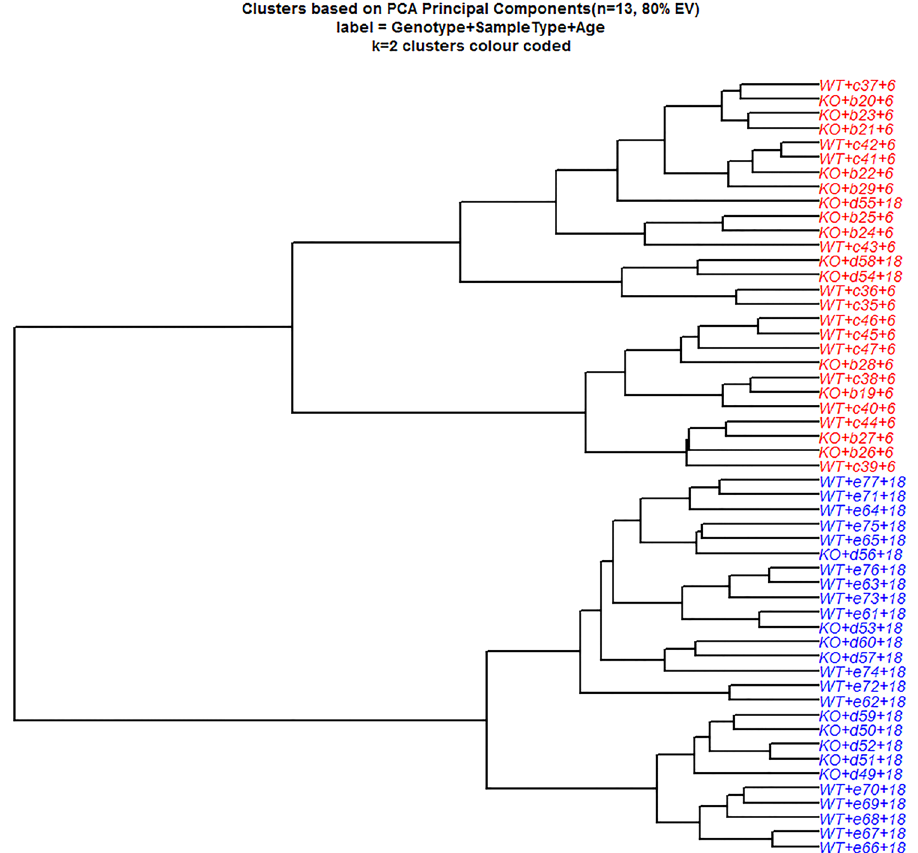
Figure 3. Stability of urinary metabolite profiles in colitis-prone mdr1a − / − animals during onset of inflammation. Principal Components Analysis (PCA) of mass ions measured by LC-MS for urine samples from mdr1a − / − mice and WT littermate controls at 6 and 18 weeks of age. Clustering of PCA data separated samples according to age, which accounted for 41.7% of the total variance. Data are shown in a dendrogram.